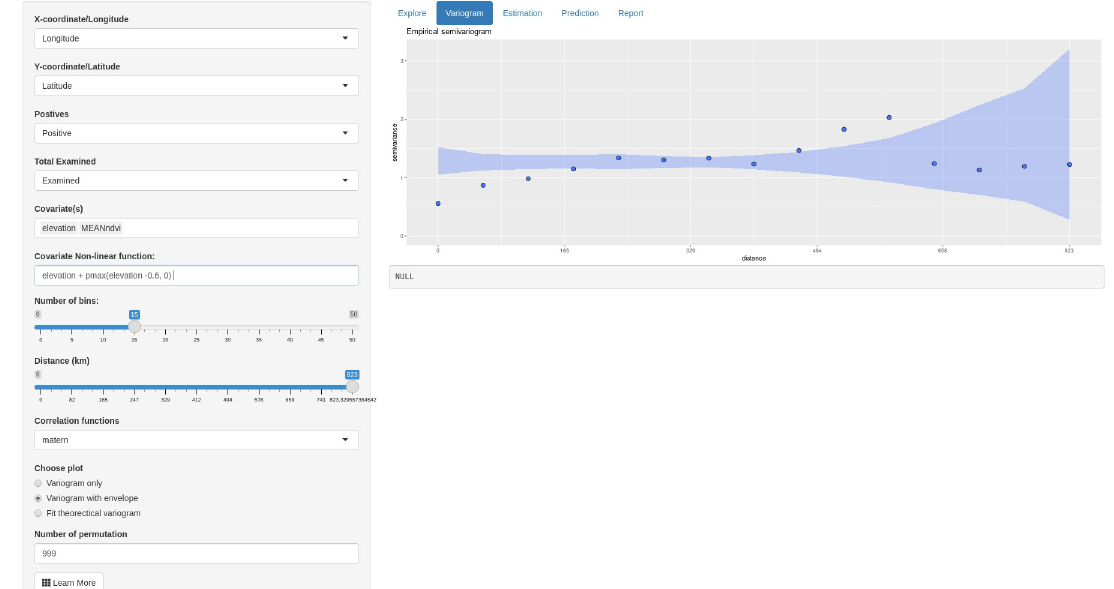
Fig 3. Variogram. Plot showing the empirical variogram and the envelope for confirming the evidence of spatial dependency.